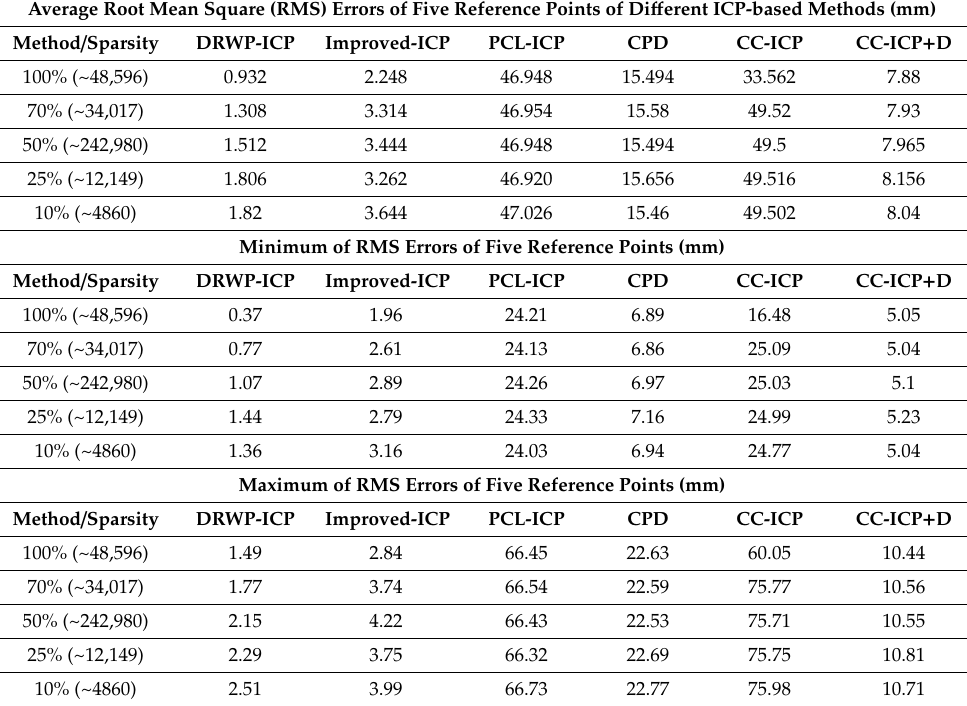
Table 1. The Average, Minimum and Maximum of Reference Points’ Alignment Errors.